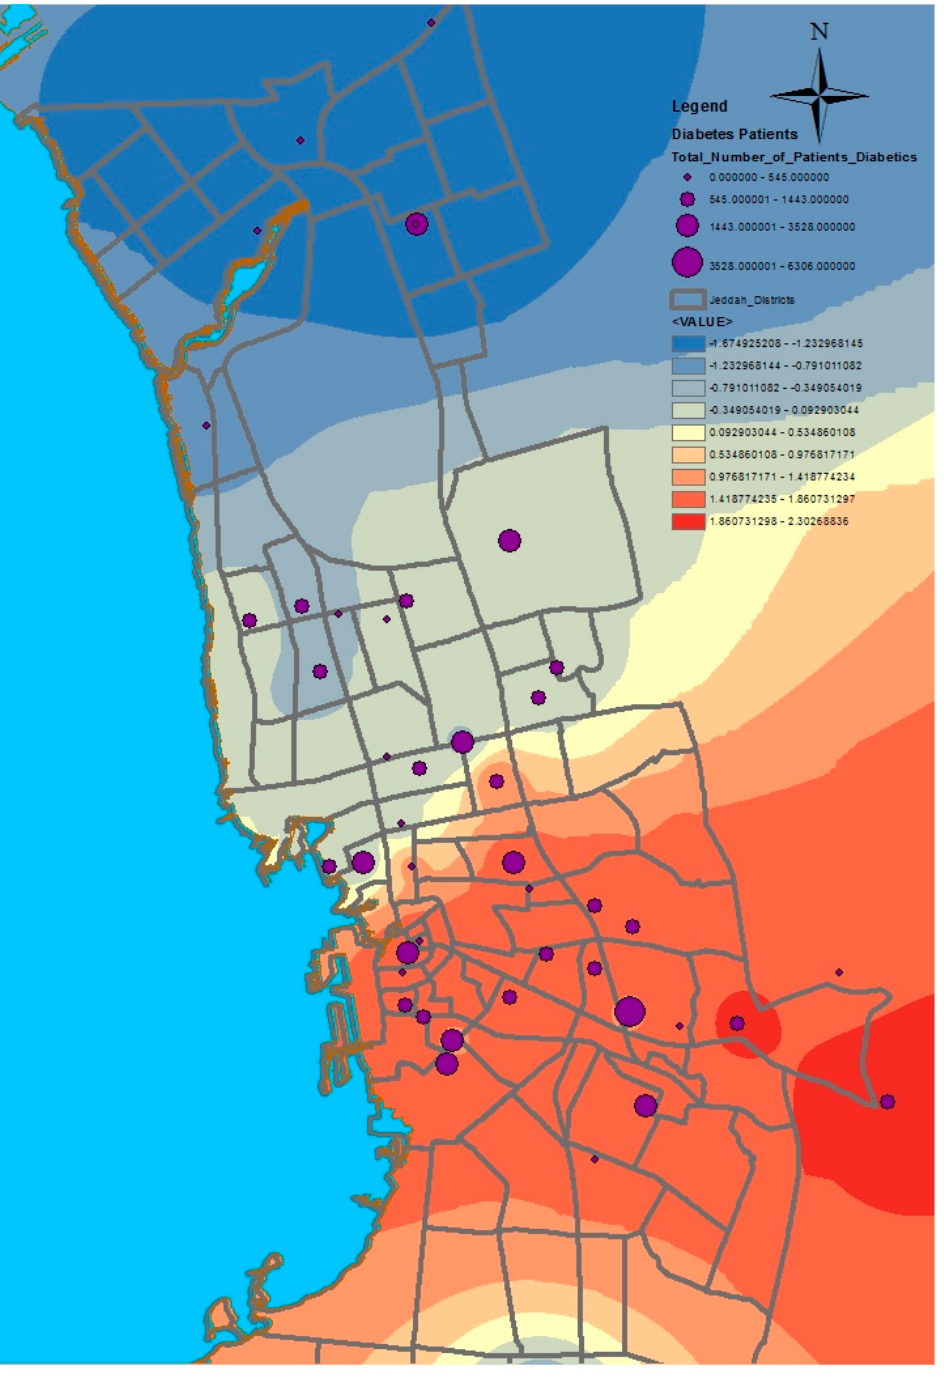
Figure 12. Hotspot analysis for diabetes patients.